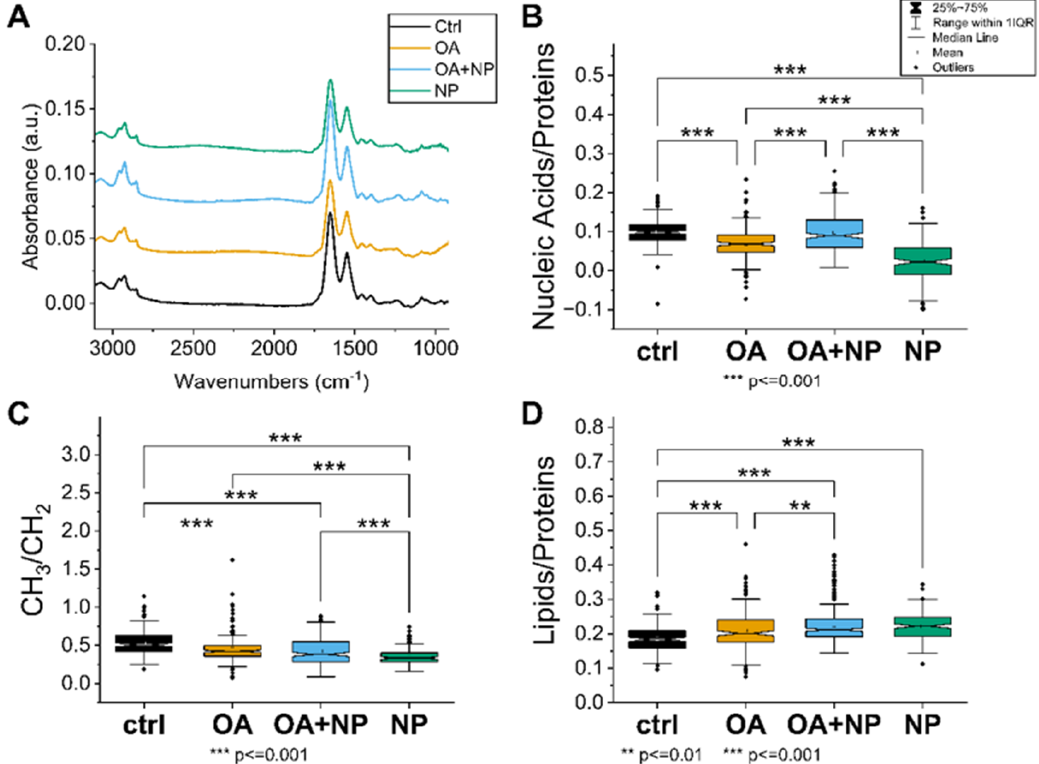
Figure 5. ( A ) Average spectra of the four analyzed cell groups after preprocessing, from bottom to top: Controls (CTRL) in black (average of 174 spectra), cells treated with oleic acid (OA) in yellow (average of 225 spectra), cells treated with OA+ silica-coated SPIONs (OA + nanoparticles (NP)) in blue (average of 280 spectra), and in green the average spectrum of SPION-treated cells (NP, average of 188 spectra). ( B ) Violin plot of the ratio of nucleic acid bands to total proteins. ( C ) Violin plot of the ratio of lipid bands to total amount of proteins. ( D ) Violin plot of the ratio of CH 3 to CH 2 bands of lipids. The same visualization parameters were used for all violin plots: CTRL in black, OA in yellow, OA + NP in blue, and NP in green. Values are sorted from the lowest value on the left to the highest on the right. Statistically significant differences in mean values are marked (**, p < 0.01; ***, p < 0.001).